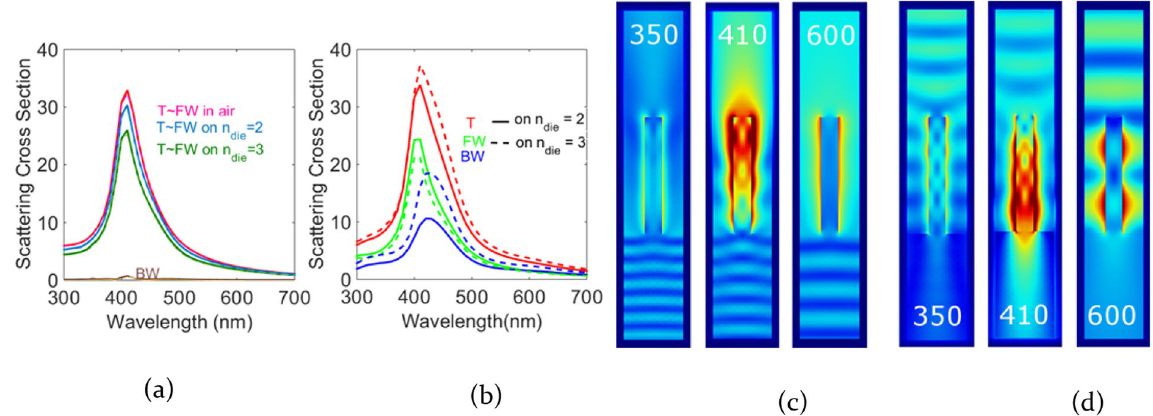
Figure 7. ( a ) Scattering cross section of a ZnO nanorod on various dielectrics with light incident from dielectric (refractive index n die ) in terms of Total (T), Forward (FW) and Backward (BW) ( b ) Scattering cross section of a ZnO nanorod for light incident directly on the nanorod ( c ) Near field images for light incident on the dielectric with index 2 at wavelengths 350, 410 and 600 nm ( d ) Near field images for light incident in air on the dielectric with index 2 at wavelengths 350, 410 and 600